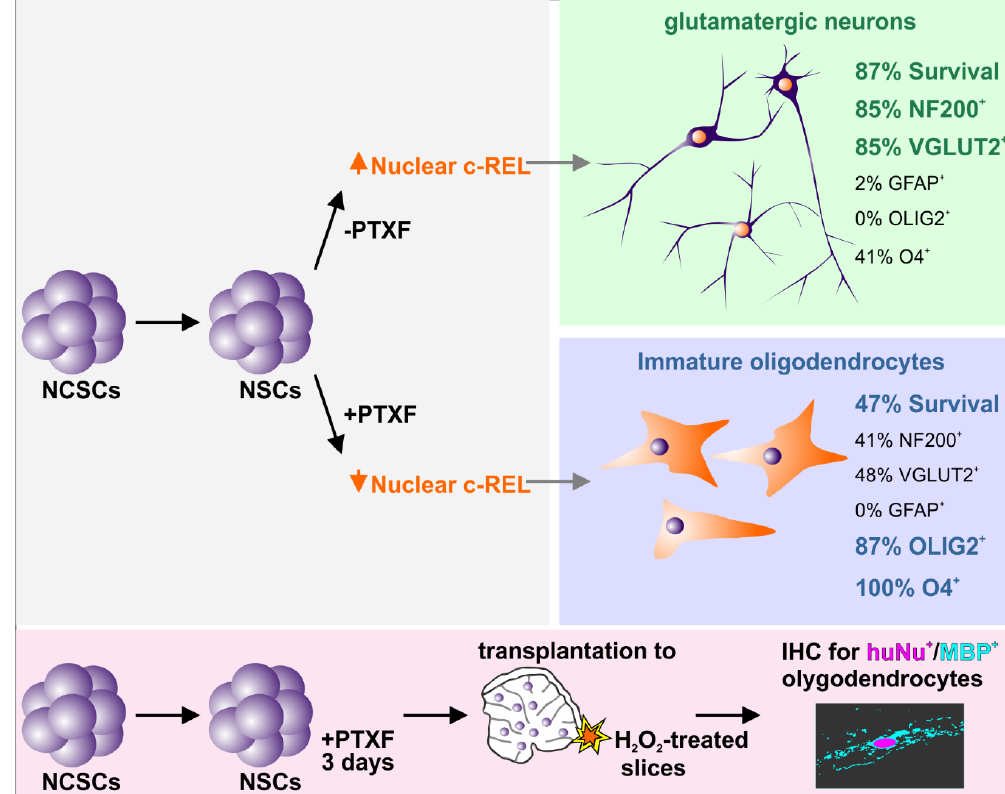
Figure 7. c-Rel inhibition drives hNSCs switch from neuronal to oligodendroglial phenotype. Upper panel: NCSCs are specified to NSCs, and differentiate upon neuronal induction into glutamatergic neurons. Cells undergo a strong increase in nuclear c-REL during early differentiation in the absence of PTXF, that induces a specific gene program expression towards the neuronal fate. Confirmed by an increased in mature neuronal markers NF200 and VGLUT2, and a strong reduction in O4, the absence of GFAP and OLIG2 accompanied by a strong survival, whereas PTXF-treated differentiated NSCs had no increase in nuclear c-REL, leading to a shift in the cell fate into the oligodendrocyte lineage. This was confirmed by a clear increase in oligodendrocyte markers OLIG2 and O4, and a strong reduction in neuronal markers (NF200, VGLUT2), and also accompanied by a strong reduction in cell survival. Bottom panel: Transplantation of PTXF-treated predi ff erentiated NSCs into a demyelination mouse organotypic cerebellar slice model further demonstrated their capability to di ff erentiate into MBP + oligodendrocytes and produce myelin ex vivo. Cells exhibited a clear oligodendroglial phenotype and di ff erentiated into huNu + / MBP + oligodendrocytes after 14 days of cocultivation. PTXF: pentoxifylline, NCSCs: neural crest-derived stem cells, NSCs: neural stem